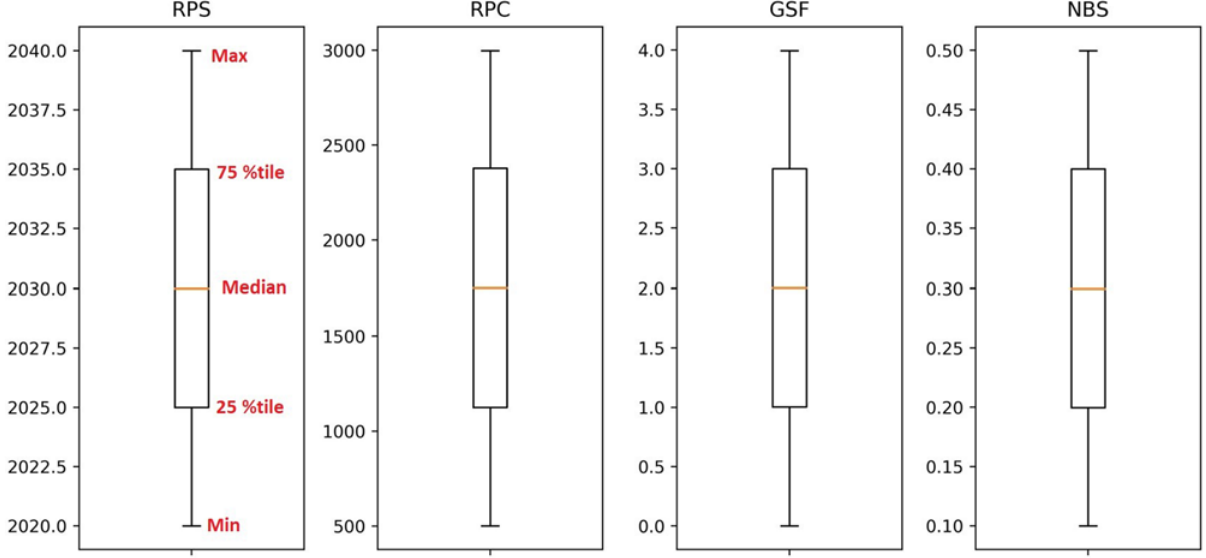
Fig. 4. Distribution of the 2400 samples by